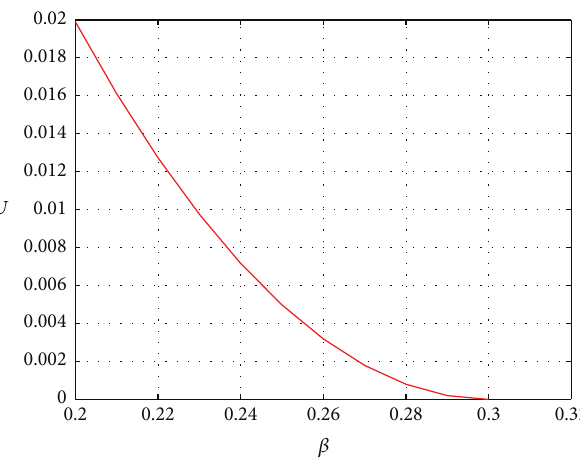
Figure 2: Diagram of the corporate information